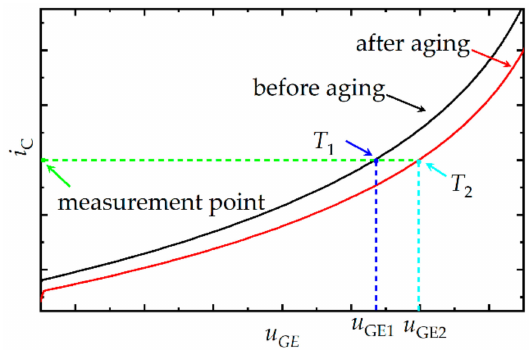
Figure 4. Transmission characteristic curve of the IGBT module before and after aging.